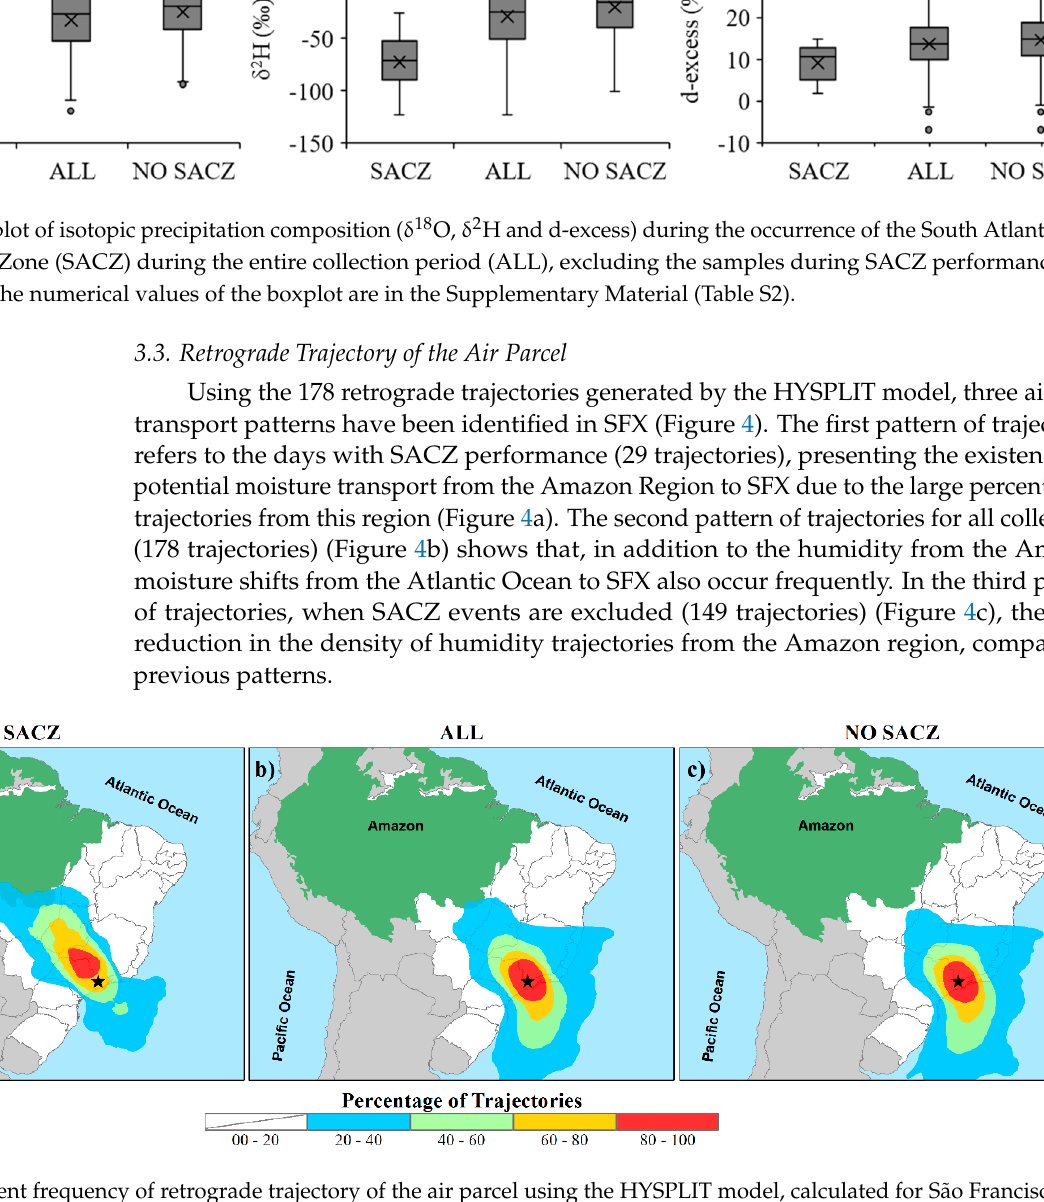
Figure 4. Percent frequency of retrograde trajectory of the air parcel using the HYSPLIT model, calculated for S ã o Francisco Xavier (black star) with 240 h return, at a 2000 m altitude, during ( a ) the occurrence of the South Atlantic Convergence Zone (SACZ), ( b ) during the entire collection period (ALL), and ( c ) excluding the samples during SACZ performance (NO